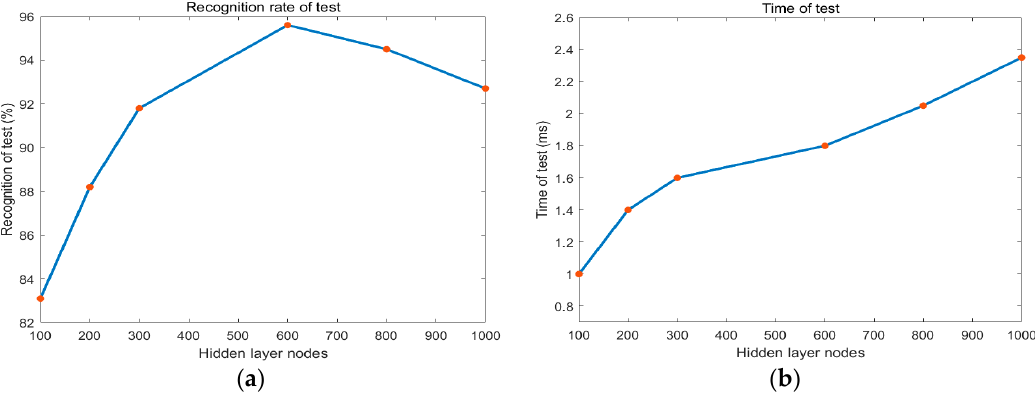
Figure 13. Sand wave detection rate and time regarding to the number of hidden layer nodes in OS-ELM. ( a ) Test recognition rate. ( b ) Test time.